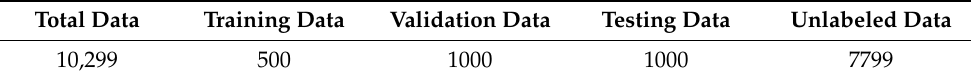
Table 3. Training/validation/testing/unlabeled separation statistics (DNN,